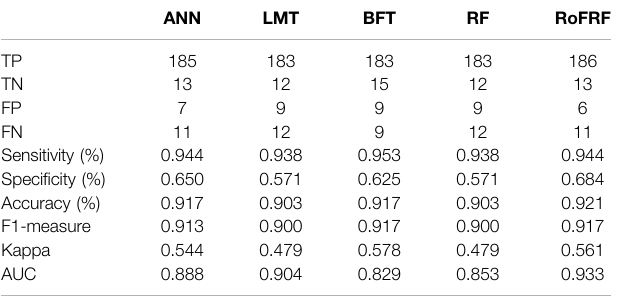
TABLE 4 | Model results using the validation dataset.